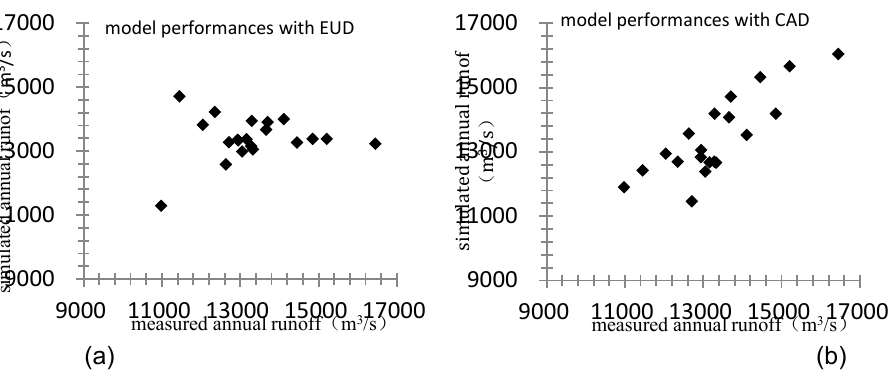
Fig. 5 Comparisons between measured and simulated annual runoff during the period of 1990–2010: (a) model performances with EUD, and (b) model performances with